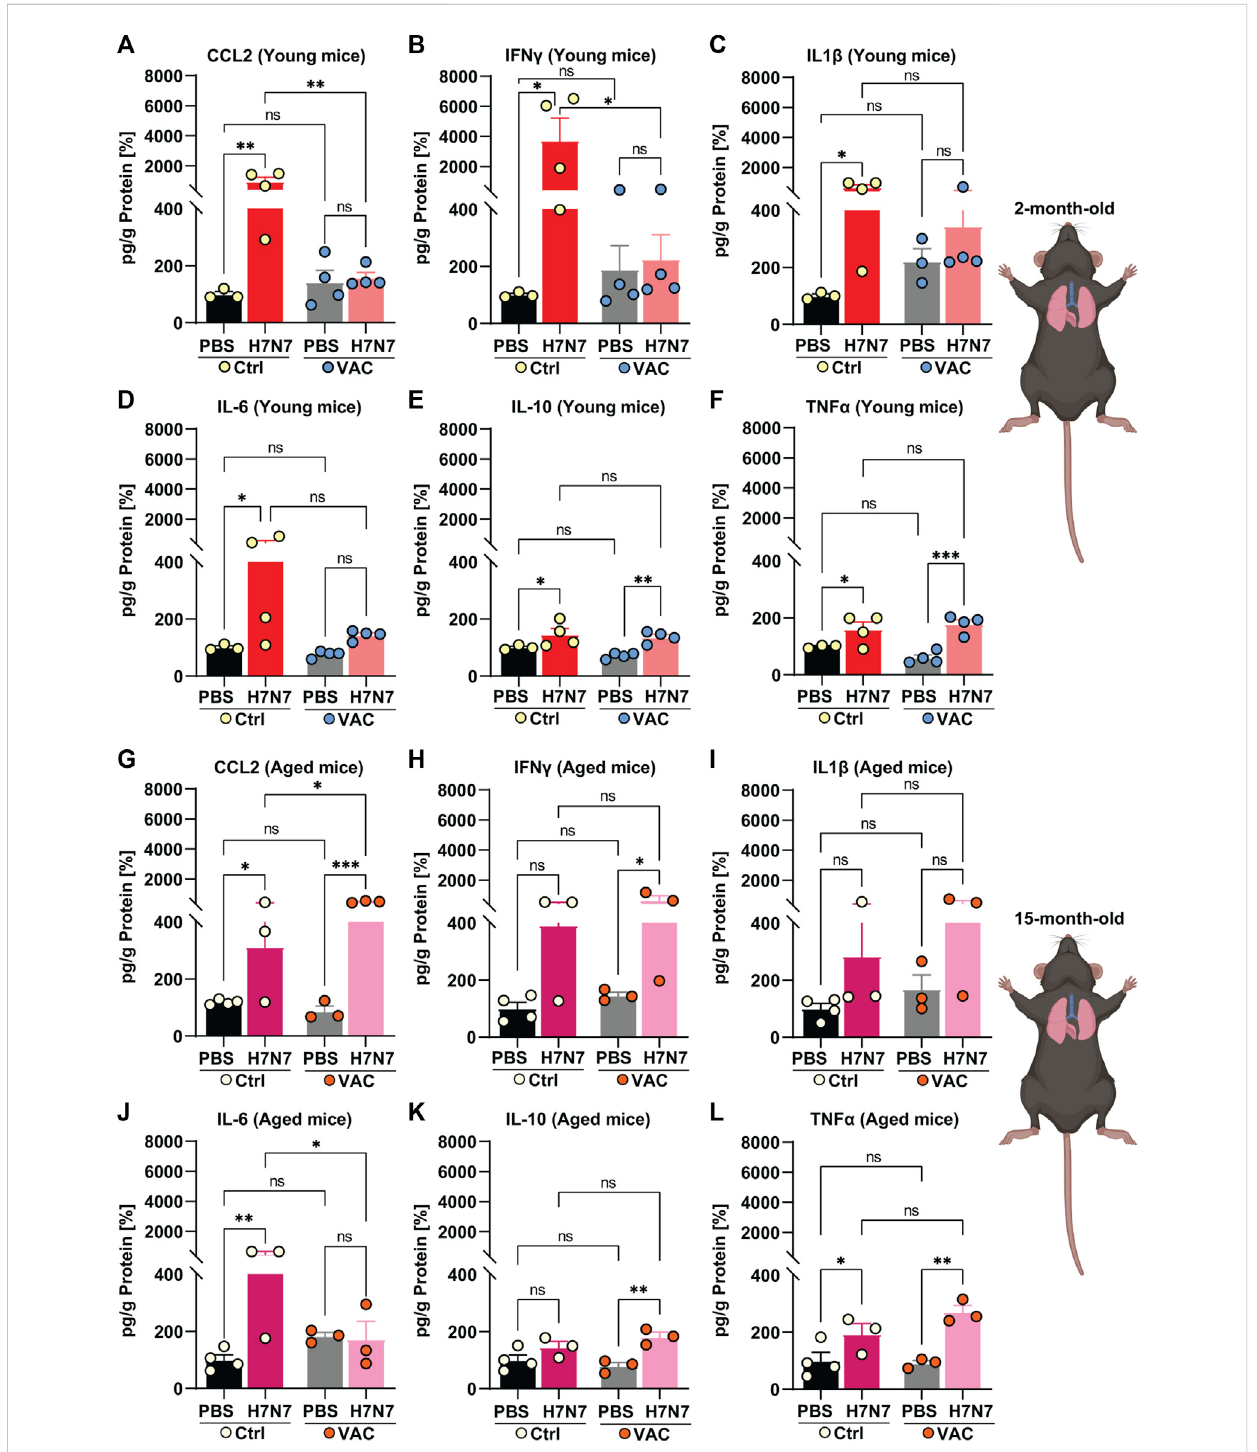
FIGURE 2 EffectsofvaccinationonthereleaseofcytokinesandchemokinesinthelunginducedbyH7N7IAVinfection.Inthelungsofyoungmice,levelsof (A) CCL2 and (B) IFN γ increased after H7N7 IAV infection, whereas vaccination preventedthisincrease and resulted ina signi fi cant decrease in therelease of these mediators in infected mice. H7N7 IAV infection led to a signi fi cant increase in the levels of (C) IL1 β and (D) IL-6 only in the unvaccinated mice. H7N7 IAV infection resulted in increased levels of (E) IL-10 and (F) TNF α in the lungs of young mice, regardless of whether they were vaccinated or not( n =3 – 4animalspergroup).Inthelungsofoldermice,H7N7IAVinfectionresultedinincreasedreleaseof (G) CCL2, (H) IFN γ ,and (I) IL1 β independent of vaccination. CCL2 levels were even higher in the lungs of infected mice that had been previously vaccinated. (J) IL-6 levels increased only in the lungs of old unvaccinated mice after H7N7 IAV infection. (K) IL-10 levels increased only in the lungs of vaccinated mice after infection. H7N7 IAV infection resultedinincreased (L) TNF α levelsinthelungsofagedmice,whethervaccinatedornot( n =3 – 4animalspergroup).Dataarepresentedasmean±SEM and were analyzed with an ordinary two-way ANOVA followed by Fisher ’ s LSD test; * p < 0.05, ** p < 0.01, and *** p <